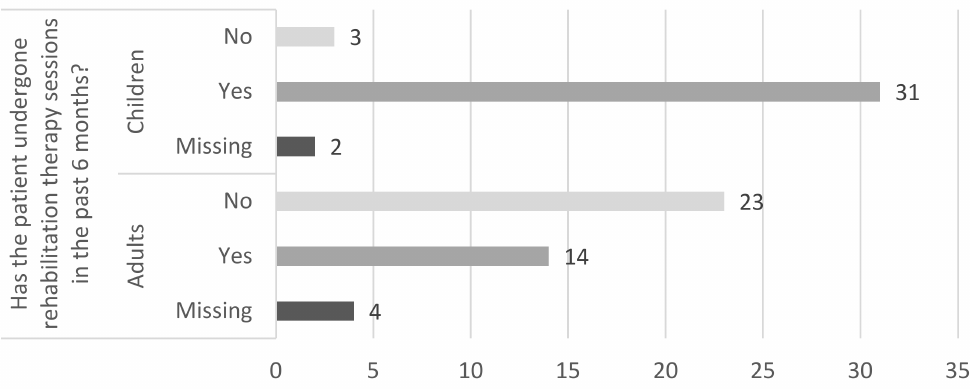
Figure 3. Distribution of patients undergoing rehabilitation in the six months before the